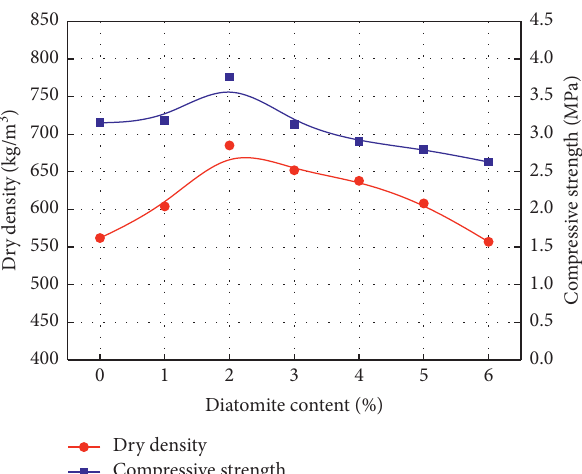
Figure 18: Dry density and compressive strength of foamed concrete under different diatomite contents.